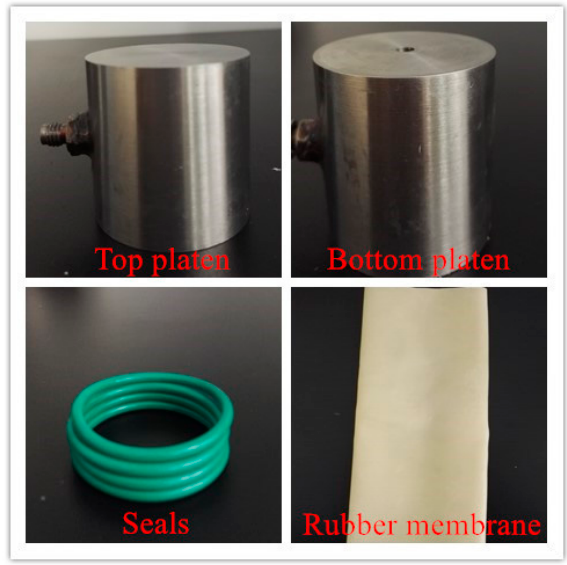
Figure 4. Appearance of the end platens, the seals, and the rubber membrane.